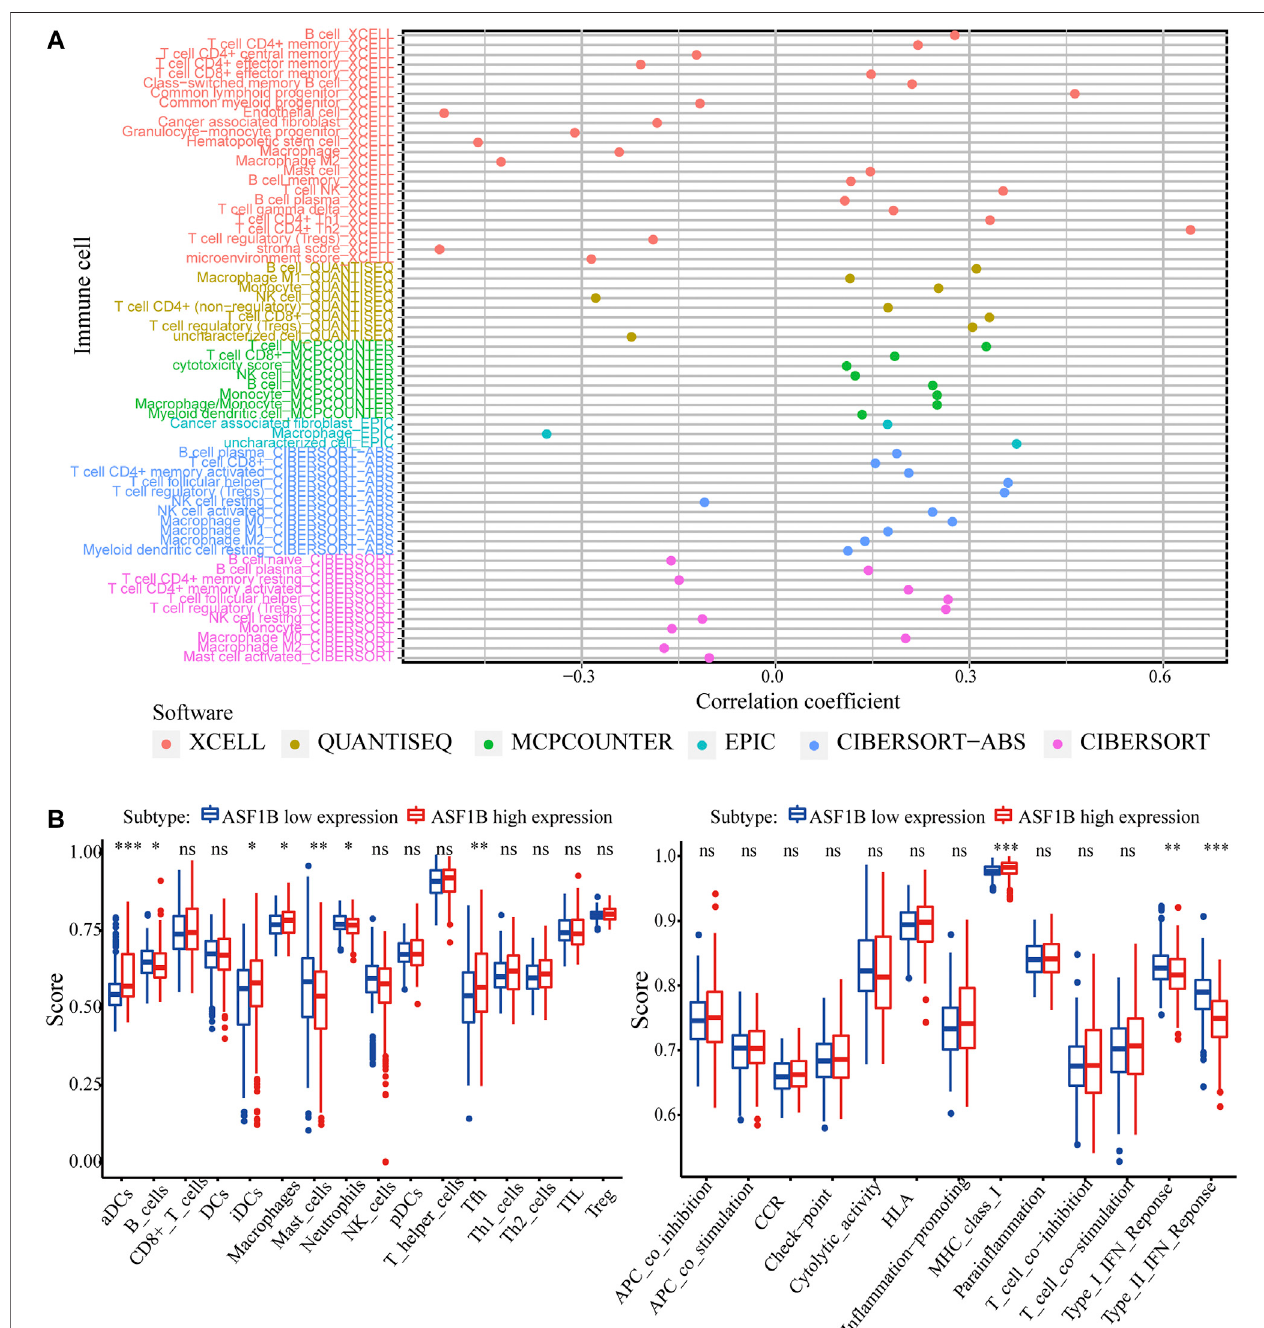
FIGURE 8 | ASF1B expression is related to immune cell in fi ltration. (A) The correlation between immune cell in fi ltration and ASF1B expression in HCC; (B) Comparison of the ssGSEA scores between high and low expression groups in the TCGA cohort. * p < 0.05; ** p < 0.01; *** p < 0.001.